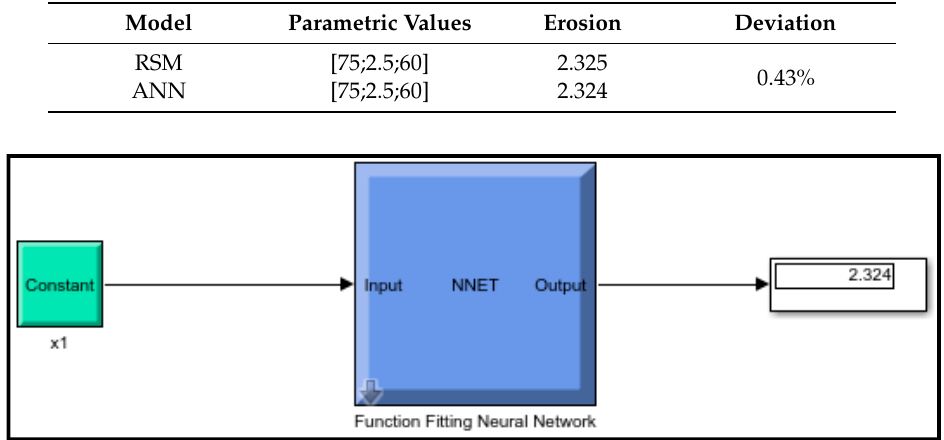
Figure 10. Developed ANN model.